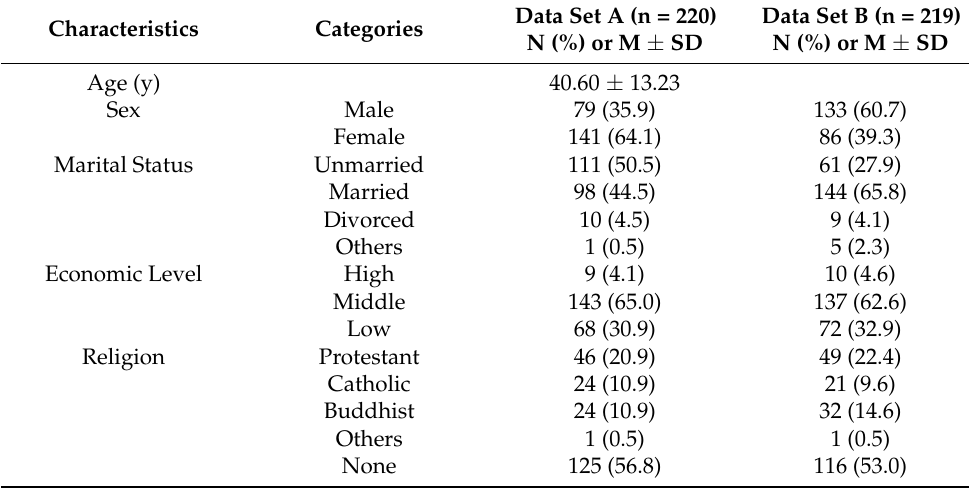
Table 1. Demographics of the